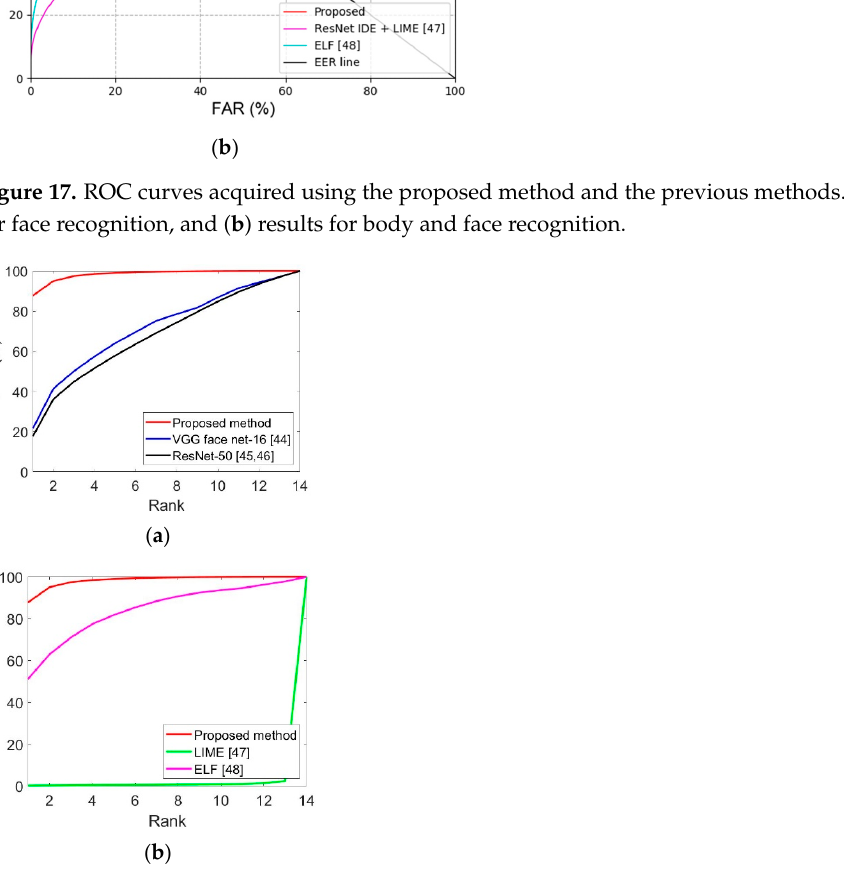
Figure 18. CMC curves of the proposed and state-of-the-art methods. ( a ) Face recognition results obtained by the proposed and state-of-the-art methods, and ( b ) face and body recognition results obtained by the proposed and state-of-the-art methods. Figure 19 represents the statistical performance dissimilarity obtained by estimating the t-test and Cohen’s d-value results of the proposed method and the second best method. For face recognition, the d-value between the proposed method and VGG face net-16 [44] is 7.07, thus having a significant effect (large effect size) because the value is greater than 0.8, while the p-value of the t-test results is around 0.019, which indicates a significant difference with the proposed method at a confidence level of 95%. Further- more, for body and face recognition, the t-test and Cohen’s d-value results were estimated with respect to ELF [48], which has the second best performance in comparison with the proposed method, where Cohen’s d-value was 7.51; this implies that there was a signifi- cant effect (large effect size), while the t-test results had a significant difference at a 95% confidence level.